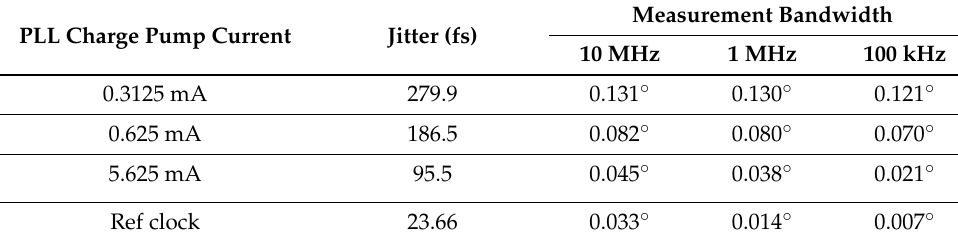
Table 5. Rms phase stability measured in different bandwidths for different charge pump current of the clock PLL, compared to the Rohde and Schwarz SMA100B clock